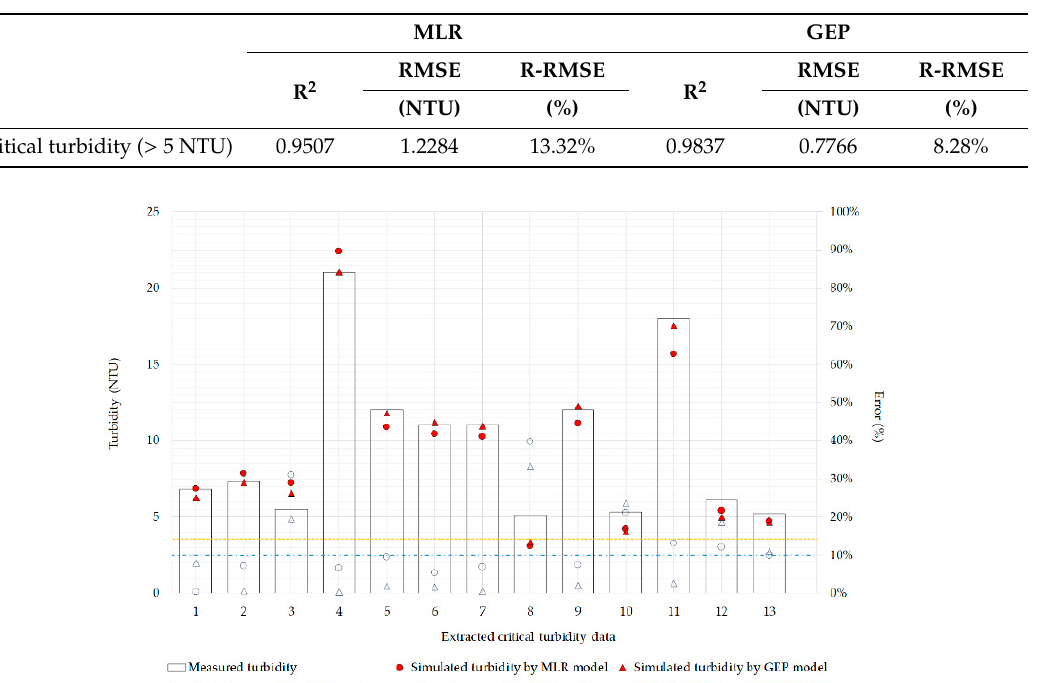
Table 6. The model comparison of critical turbidity condition.